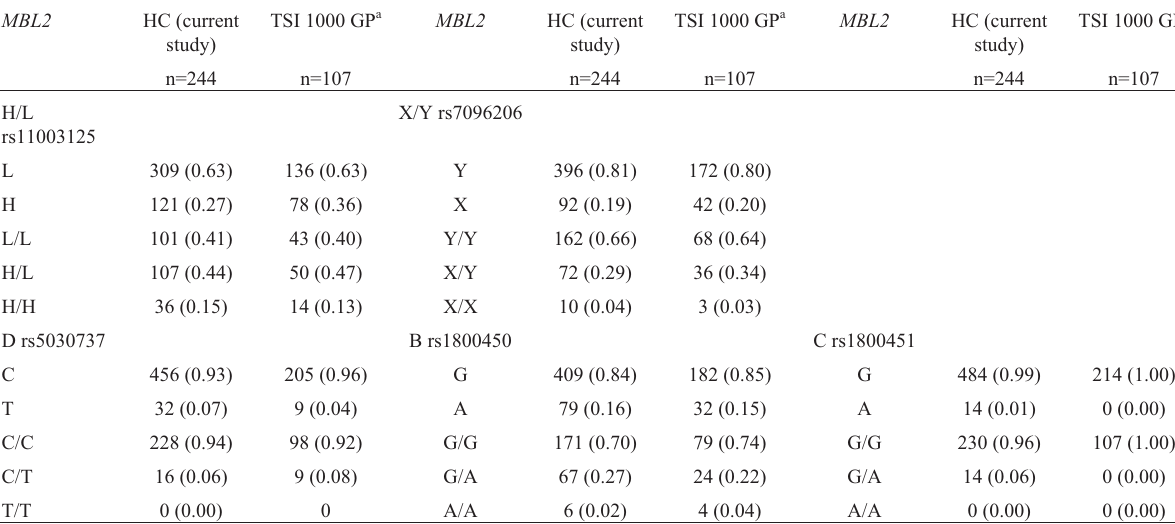
Table 2 - MBL2 allele and genotype frequencies in the present study and Tuscan